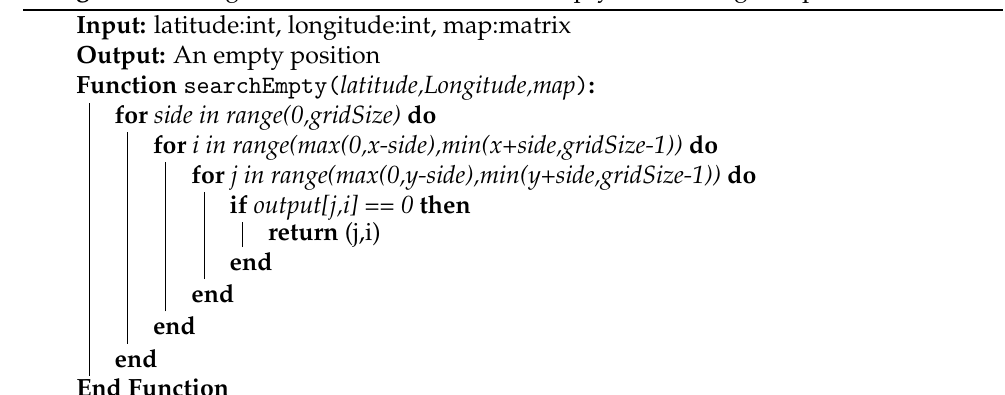
Algorithm 1: Algorithm that searches for an empty cell near a given